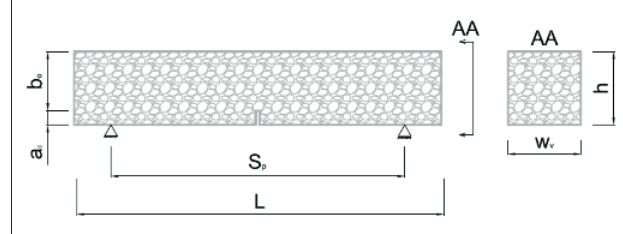
Figure 7 – Scheme of the beam in three-point- bending indicating the geometric